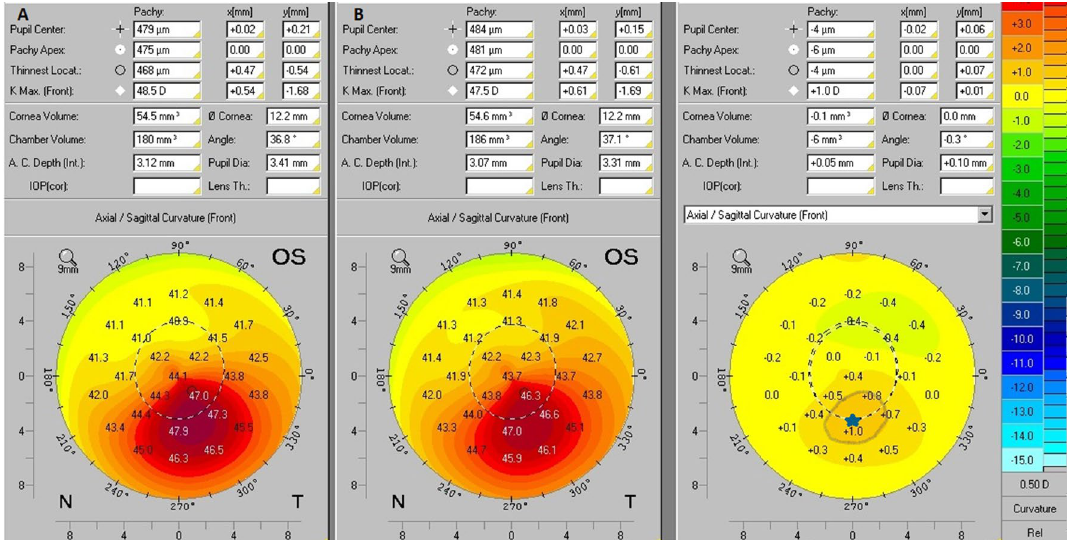
Figure 2. Anterior axial/sagittal curvature comparative maps of Pentacam HR images. In this case, the axial/ sagittal curvature maps had an interval of 12 months. In the initial exam ( B ) the Kmax was 47.5D and in the subsequent exam ( A ) the Kmax was 48.5D, so there was progression of + 1D in this variable (blue star). On the other way, the comparative map did not show an increase of more than 1D in the anterior curvature outside the non-apical corneal zone, and therefore there was no KCE progression.